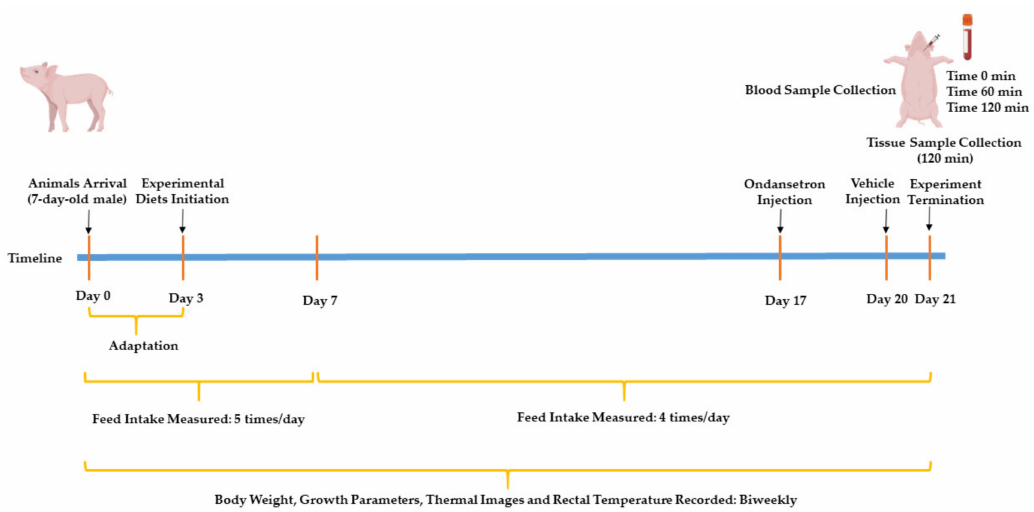
Figure 1. The experimental timeline. Seven-day-old male piglets arrived on day zero and were assigned to low birthweight (LBW) or normal birthweight (NBW) groups, according to their body weight. Following three days of adaptation, LBW pigs were weight-matched, and then NBW and LBW pigs were subjected to one of four dietary treatments, including: NBW-T0, normal-birthweight piglets fed a basal diet without supplemented L-tryptophan (Trp); LBW-T0, low-birthweight piglets fed a basal diet without supplemented Trp; LBW-T0.4, low-birthweight piglets fed a basal diet supplemented with 0.4% Trp; and LBW-T0.8, low-birthweight piglets fed a basal diet supplemented with 0.8% Trp. Following overnight fasting, all pigs received injections of ondansetron and saline on day 17 and 20, respectively. The feed intake was measured 5 times/day during the first week and 4 times/day during the last two weeks of the study. The body weight, growth parameters, thermal images, and rectal temperature were recorded biweekly throughout the study. After an overnight fast at week three, the pigs were allowed to consume their respective diets for 1 h (meal test). Blood samples were then collected at baseline and then at 60 and 120 min after the meal test. Following blood collection at 120 min after the meal test, all pigs were euthanized, and tissue samples were